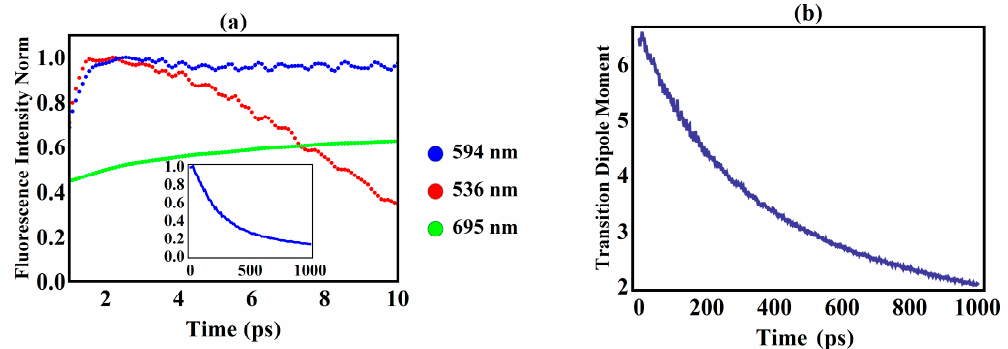
Figure 4. ( a ) Time evolution of the fluorescence intensity for three different wavelengths, where the inset plot is 1 ns evolution for the wavelength of 594 nm; ( b ) Change of the square of the total transition dipole moment during 1 ns (the units of the vertical axis are e 2 Å 2 ).